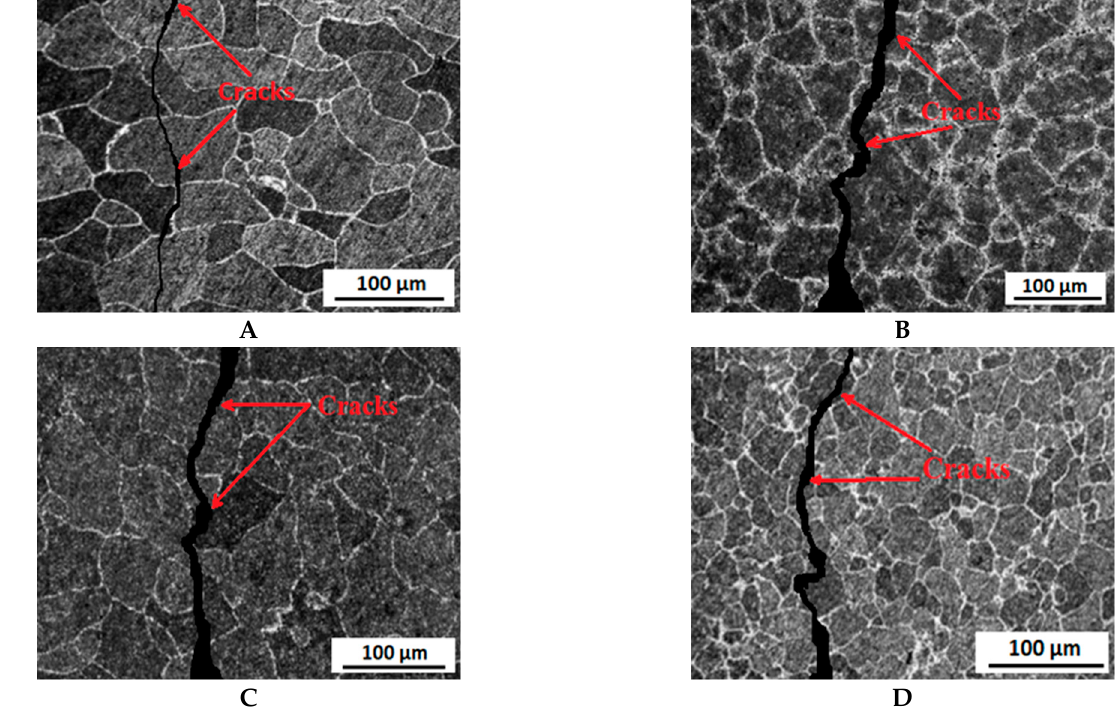
Figure 7. Microstructural analysis of the failed surfaces of Al5083 alloy tested in air for the ( A ) as-received sample and samples after the ( B ) 1st pass, ( C ) 2nd pass, and ( D ) 3rd pass.